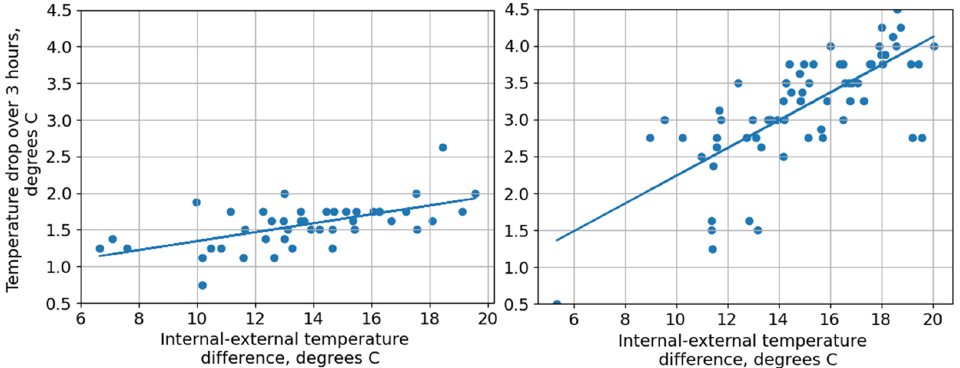
Figure 2. Temperature drop over three hour period, for the LEEDR houses in Figure 1. Left : House 05. Right : house 39.